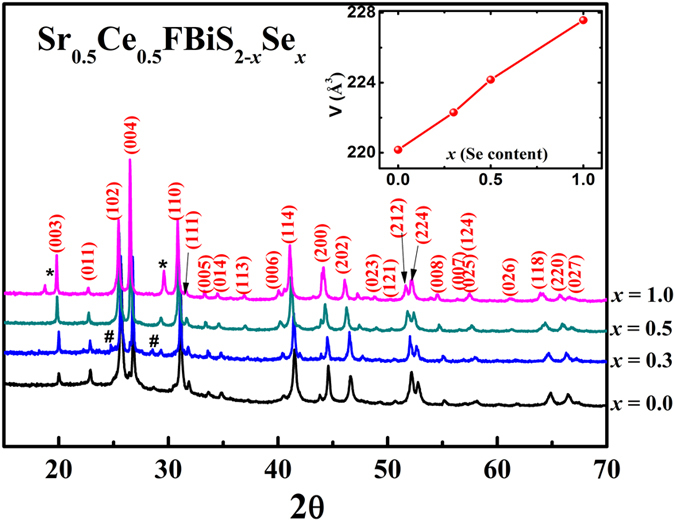
Powder X-ray diffraction of Sr0.5Ce0.5FBiS2-xSex(x = 0.0, 0.3, 0.5 and 1.0). Symbols (*) and (#) indicate impurity phases Bi2Se3 and Bi2S3 respectively. Inset shows the variation of cell volume with Se content.